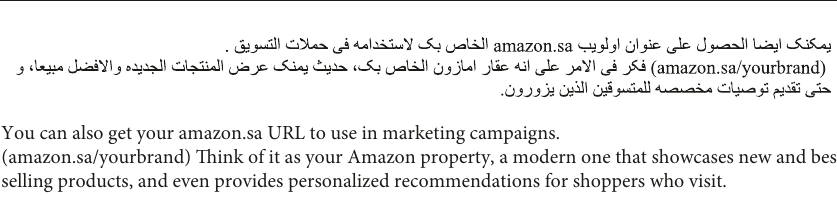
Figure 16: An example of vague translated sections due to ungrammaticality.